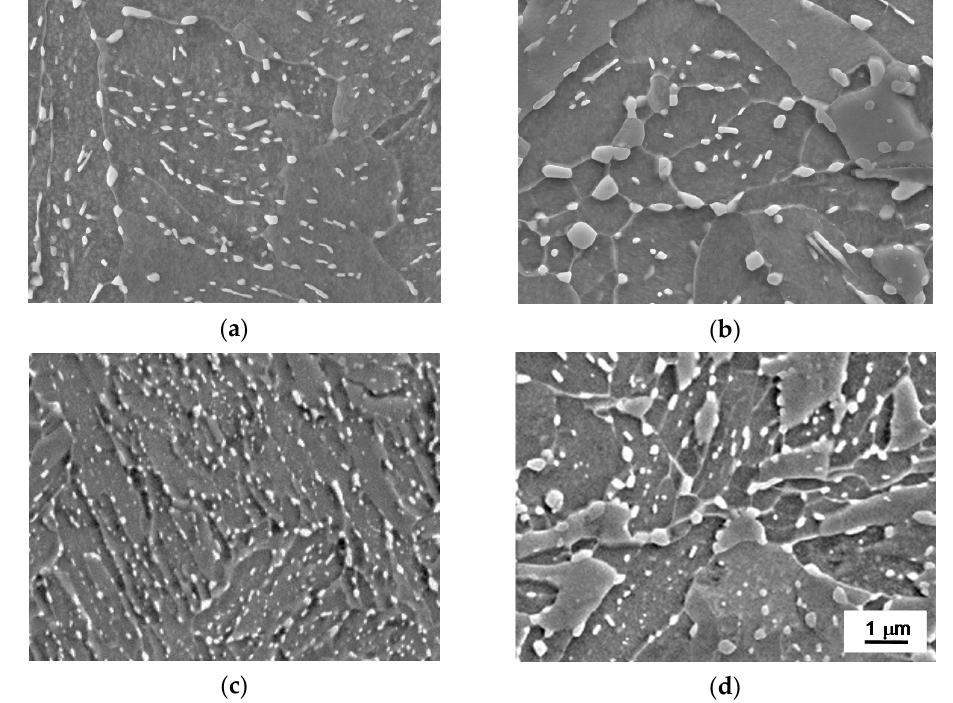
Figure 4. Bainite microstructure after short ( a ) and long ( b ) annealing treatments. Idem for martensite microstructure in ( c , d